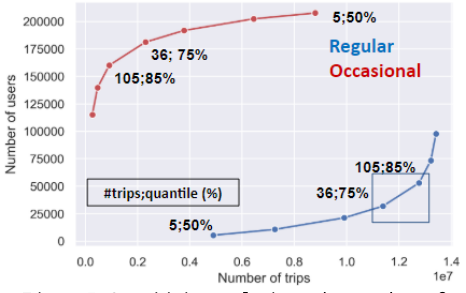
Figure 5. Sensitivity analysis on the number of “regular”/“occasional” users relative to the number of trips performed